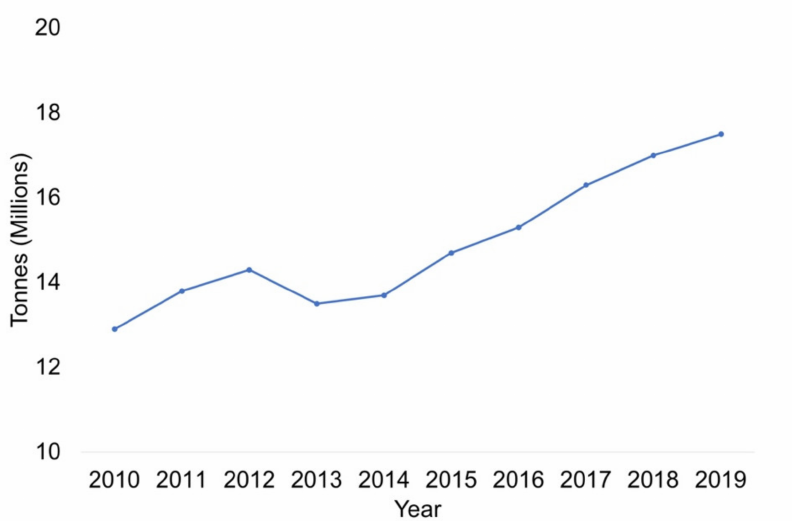
Figure 1. Worldwide nut production from 2010 to